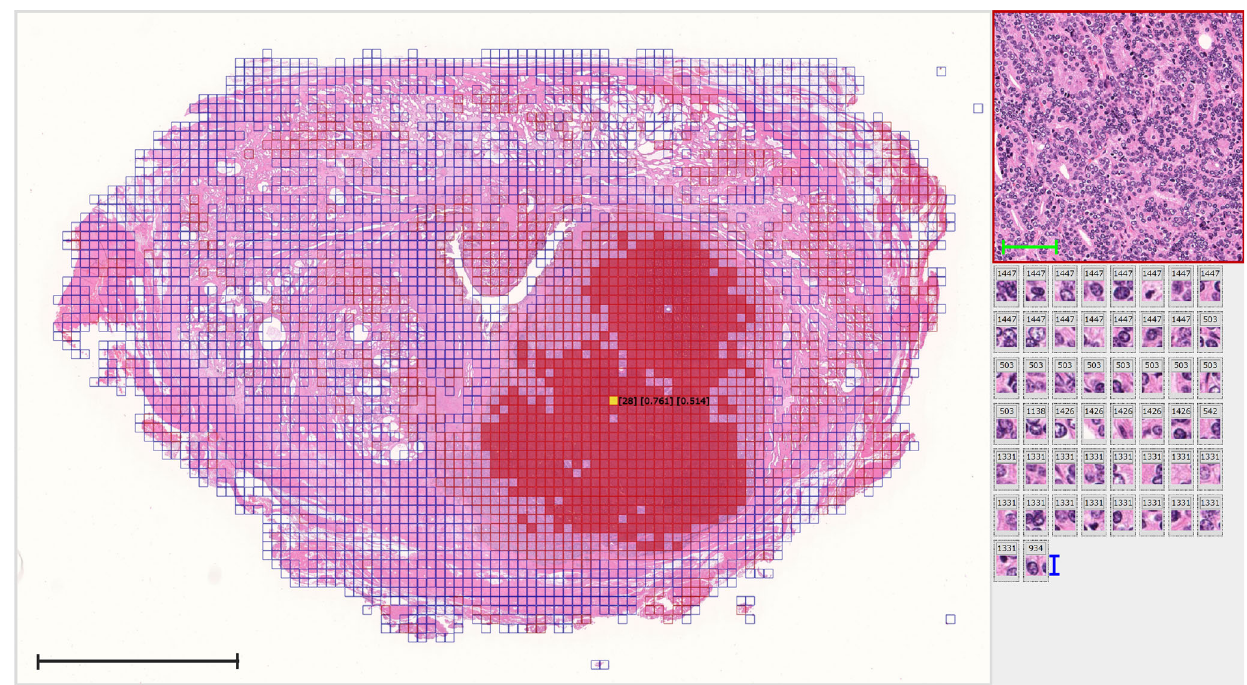
Fig. 5 Automatically annotated whole-mount pathology image. Our method directly generates key features based on the whole image without requiring a region selection step. Using the key features and cell-level information found by the deep neural networks, we automatically annotated whole-mount pathology images. Here we show an automatically annotated whole-mount pathology image (left), as well as a low-magni fi cation image of the yellow region (upper right) and the associated high-magni fi cation images with number of Step 2 feature (lower right). The regions with impact scores above and below 0.5 in Step 1 are shaded in red and blue, respectively. The indicated yellow cell shows [number of Step 1 feature (100 total features)] [impact score, Step 1] [impact score, Step 2] (see Key feature generation method in the Methods section). The black scale bar included in the image represents a length of 1 cm. The green scale bar represents a length of 100 μ m. The blue scale bar represents a length of 12.3 μ